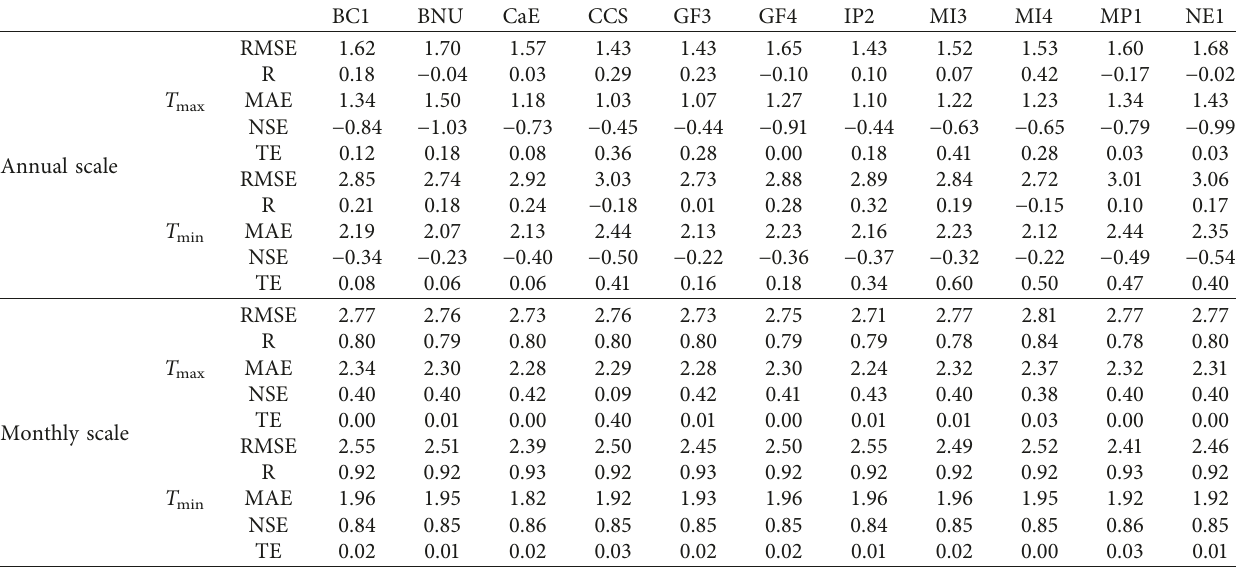
Table 5: The evaluation statistics by each climate model simulated at Luxi Station. BC1